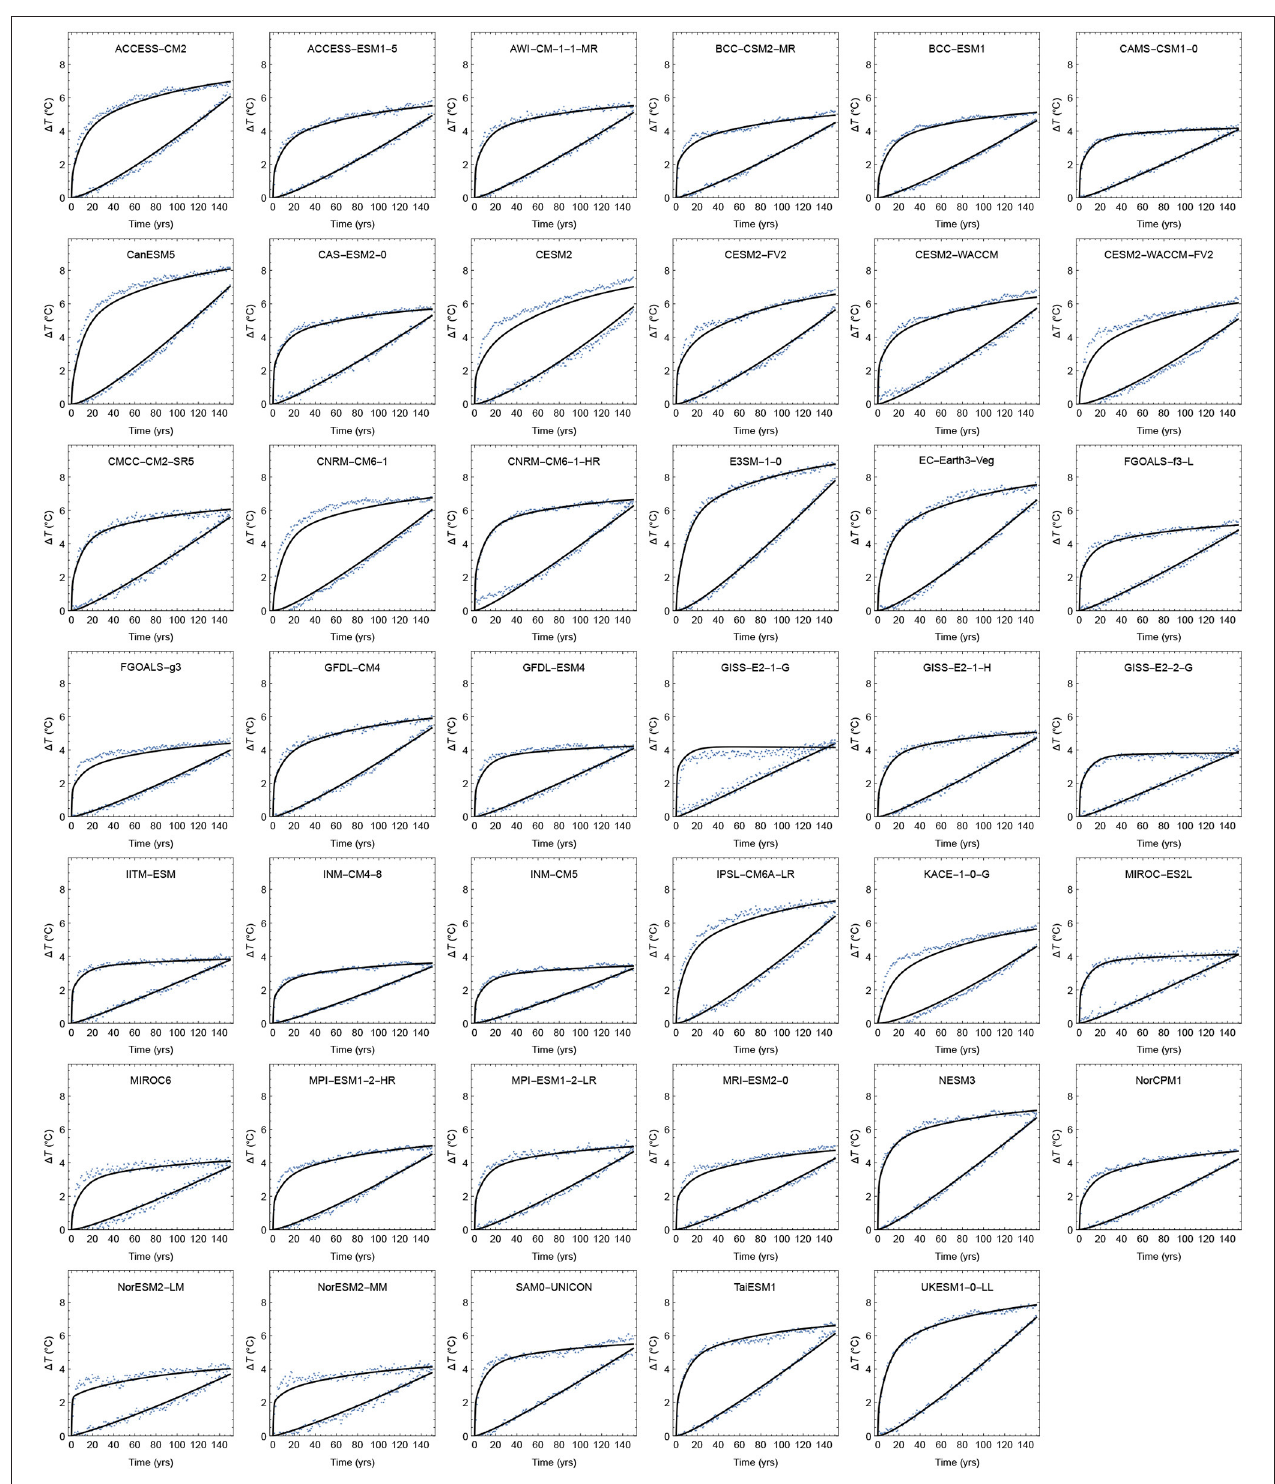
FIGURE 2 | The points are the GSAT from the first 150 yrs in 4 × CO 2 experiments and 1%-per-yr experiments in CMIP6. The solid curves are the simultaneous least-squares estimates to the two time series of a linear response to the forcings F ( t ) = F 4 × CO